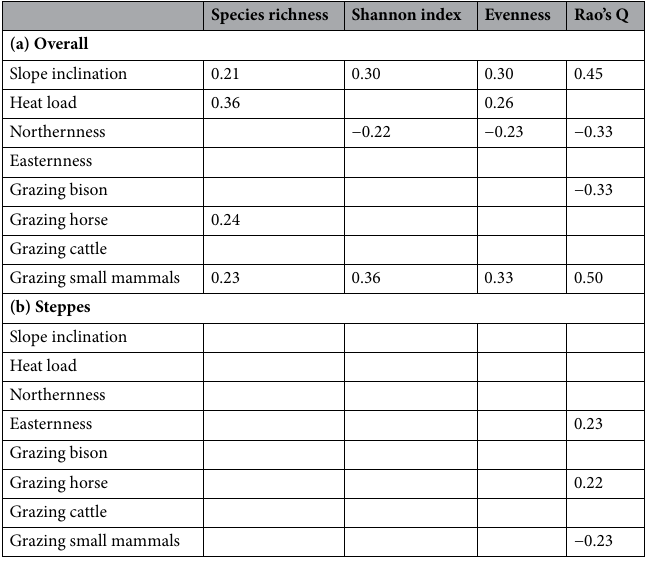
Table 4. Correlations of taxonomic and functional diversity with environmental variables. Spearman correlations of taxonomic (species richness, Shannon, Evenness) and functional (Rao’s Q) diversity indices with environmental variables for microclimate and grazing impact for a) the overall data set, as well as b) separately for steppes. Spearman’s rho, only values > 0.2 are given.